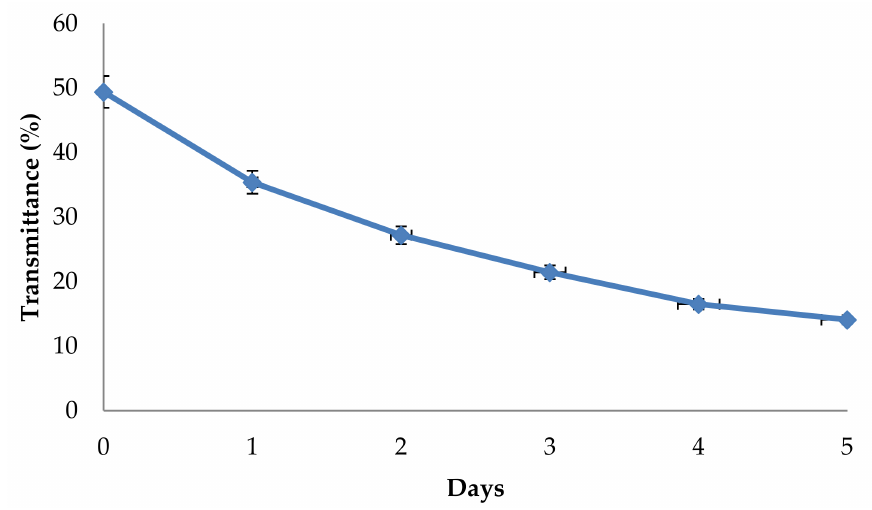
Figure 4. Light transmittance values (%) of proso millet